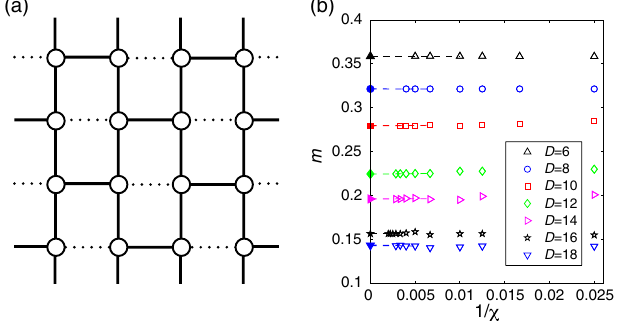
FIG. 7. (a) The honeycomb lattice is mapped to a square lattice with brickwall structure. There is no Hamiltonian term between sites connected by a dotted line. A square-lattice iPEPS is used for this lattice, where we choose the bond dimension along the dotted lines as D ¼ 1 . (b) Local ordered moment as a function of inverse (cid:6) , which controls the accuracy of the contraction of the iPEPS. The values of m for different bond dimensions D depend only slightly on (cid:6)